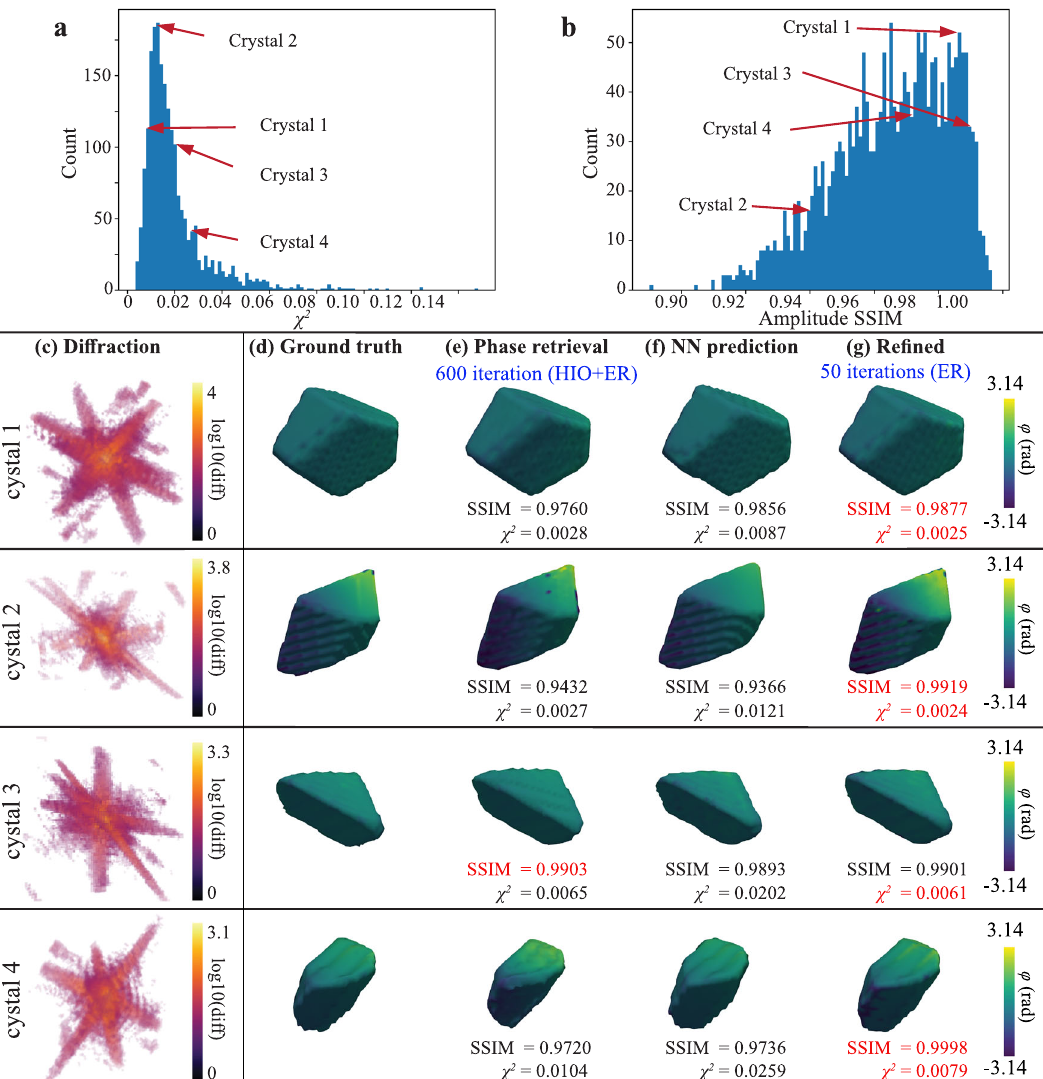
Fig. 2 Performance of AutoPhaseNN on simulated test data. a Histogram of χ 2 error for the modulus of the diffraction pattern. b Histogram of SSIM for the amplitude of the real space images. c Volume rendering of the input 3D diffraction patterns, d ground truth images, e phase retrieval results, f network predictions, and g re fi ned results, for the four representative samples. d – g Show the 0.3 contour of the amplitude and the color represents the phase on the surfaces. Reciprocal χ 2 errors and SSIMs for the amplitude of real space images are shown in the fi gures. The best fi gure of merit for each crystal is marked in numerical modeling of diffraction and custom layers to enforce image shape support (Fig. 1b). The outputs of the 3D CNN, amplitude and phase images, are combined to form the complex number, which is input to the X-ray scattering model to obtain the estimated reciprocal space intensity. Loss for each training example is then computed as the mean absolute error (MAE) between measured and estimated diffraction intensities. The loss function is de fi ned as: